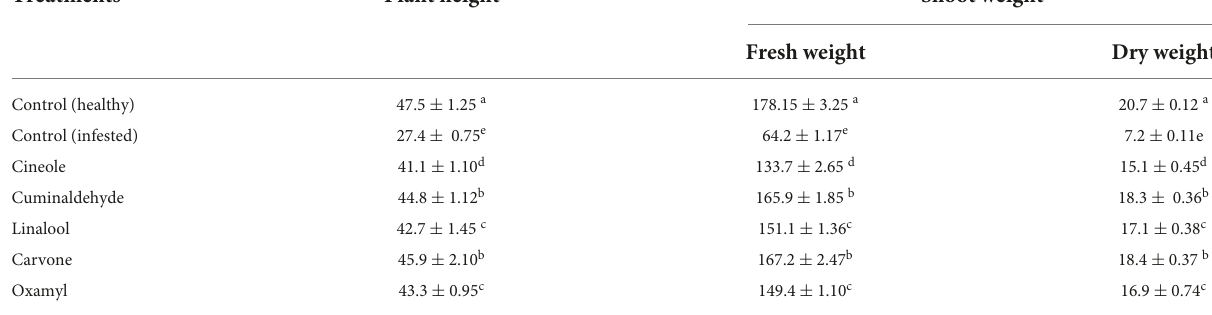
TABLE 4 Effect of treatments on the plant height (cm), shoot fresh and dry weights